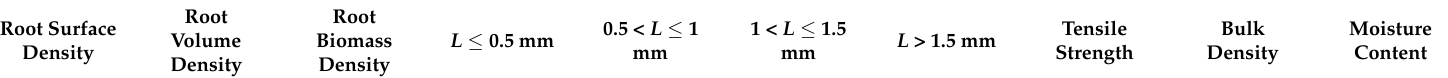
Table 8. Correlation coefficient between the root parameters, soil properties, and shear